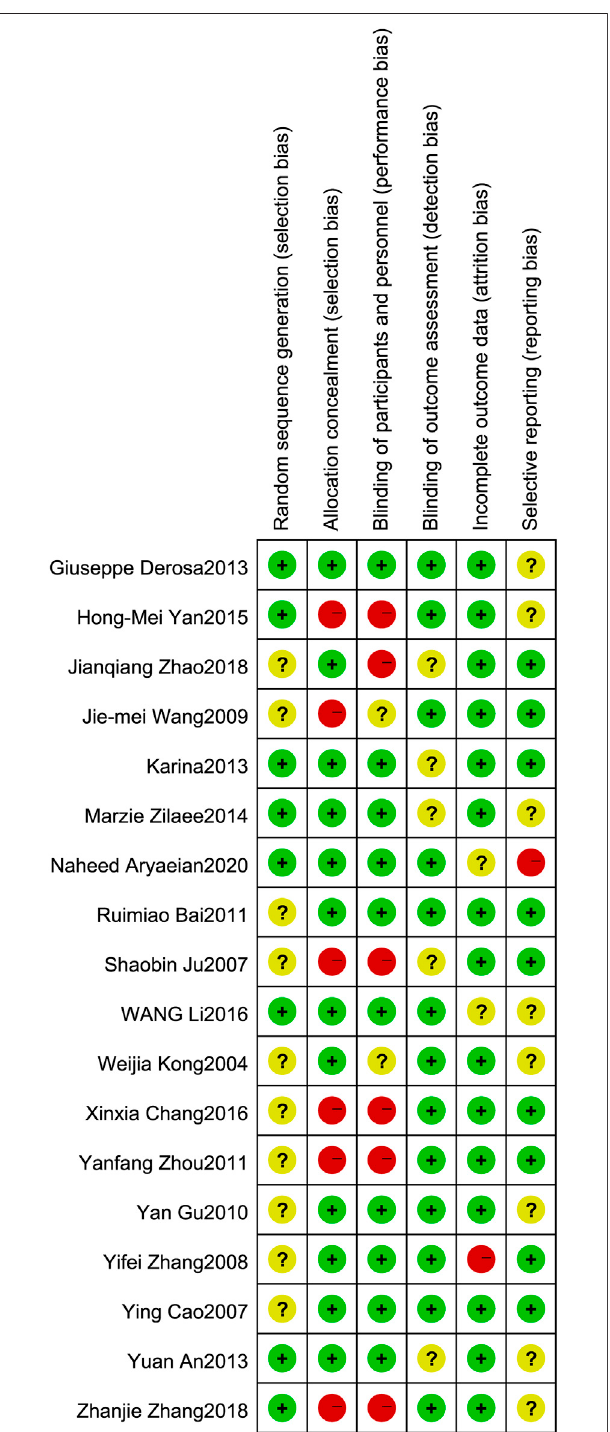
FIGURE 2 | Risk of bias assessment. The details were related to the six domains that contained (1) random sequence generation (selection bias): the literature proclaims that the random sequence method is considered low risk. (2) Allocation concealment (selection bias): explain that allocation